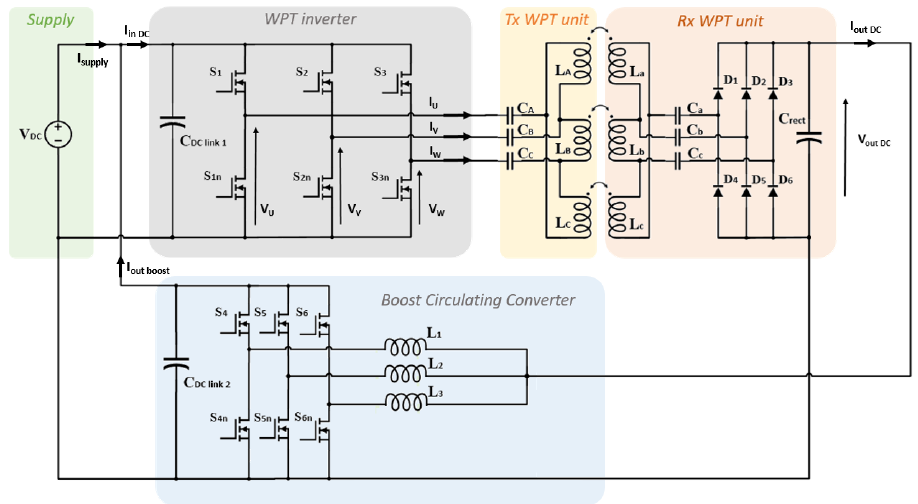
Figure 5. Electric scheme of the opposition-method configuration for the WPT